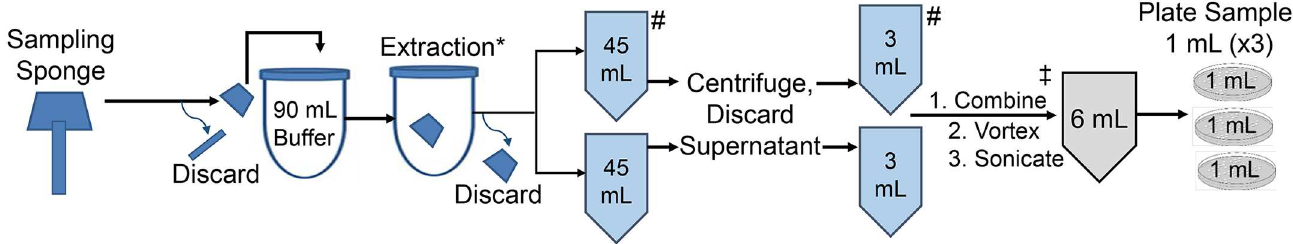
Fig 2. Pictorial overview of the sample process and analysis method for each sampling sponge. * For sponges used with the multi-medium multi-pass composite (MM-MPC) method, each of the sponges used for samplingwere extracted one at a time, in the same 90 mL buffer. # The volume followingextraction was > 90 mL (up to 105 mL) for MM-MPC samples; therefore, the sample was split into three aliquots prior to being combined. ‡ The final target volume for all methods was 6 mL, includingthe MM-MPC